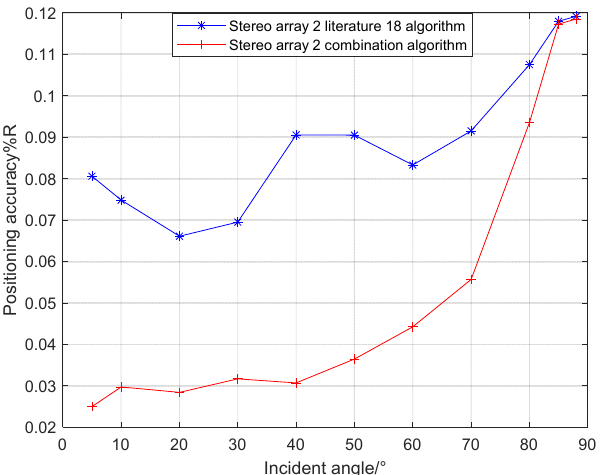
Figure 20. Comparison between combination algorithm and literature 18 algorithm for stereo array 2.